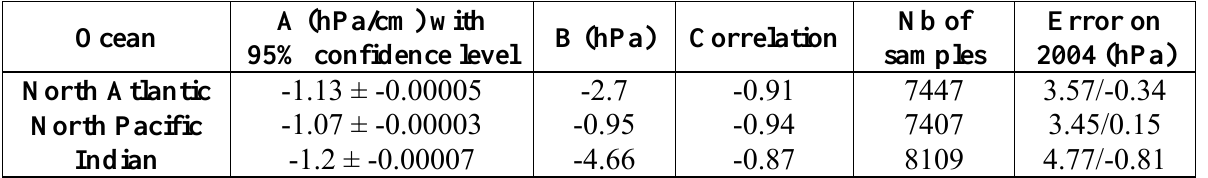
Table 4. SLP-MOG2D Sea level regression models for 2003 extra-tropical